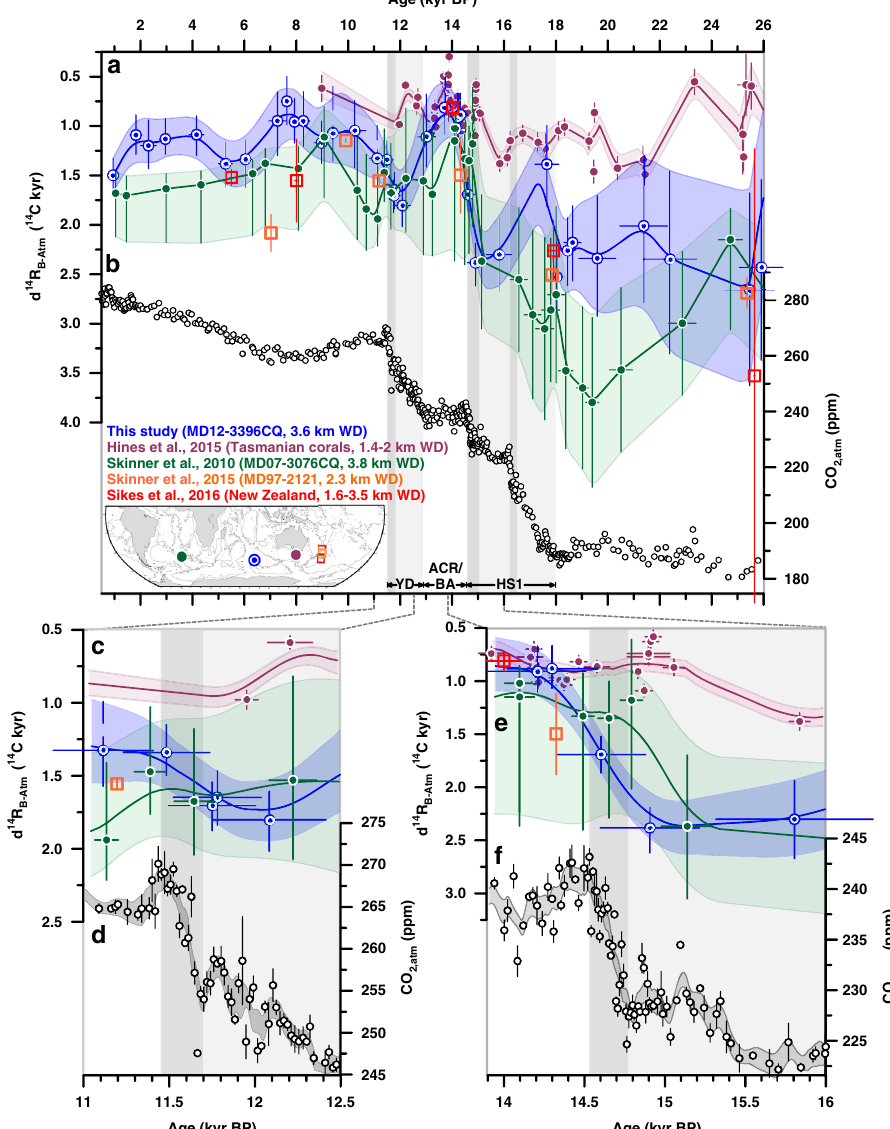
Fig. 5 Deglacial deep-ocean reservoir age variations in the Southern Ocean. a , c , e Benthic foraminiferal 14 C age offsets in MD12-3396CQ (3.6 km water depth, WD) from the contemporaneous atmosphere, d 14 R B-Atm (blue), compared to deep-ocean ventilation ages in the deep sub-Antarctic Atlantic (MD07-3076CQ, 3.8 km WD; upstream, green 5 ), on the Chatham Rise (MD97-2121, 2.3 km WD; downstream, orange 30 ), in the New Zealand area (1.6- 3.5 km WD; downstream, red 33 ), and south of Tasmania (corals, 1.4 – 1.9 km WD; downstream, purple 35 ), and b , d , f atmospheric CO 2 (CO 2,atm ) changes. Lower panels zoom in on d 14 R B-Atm variations during speci fi c intervals of rapid centennial CO 2,atm increase 32 , i.e. the ~11.7 ( c , d ) and ~14.8 kyr events ( e , f ). Lines and envelopes show 1 kyr- ( a ) and 0.5 kyr- ( c – f ) running averages and 1 σ -uncertainty-/66%-probability ranges. Vertical bars indicate intervals of rising CO 2,atm levels (dark bands highlight periods with centennial-scale CO 2,atm increases) 32 . HS1 Heinrich Stadial 1, ACR Antarctic Cold Reversal, BA Bølling Allerød, YD Younger